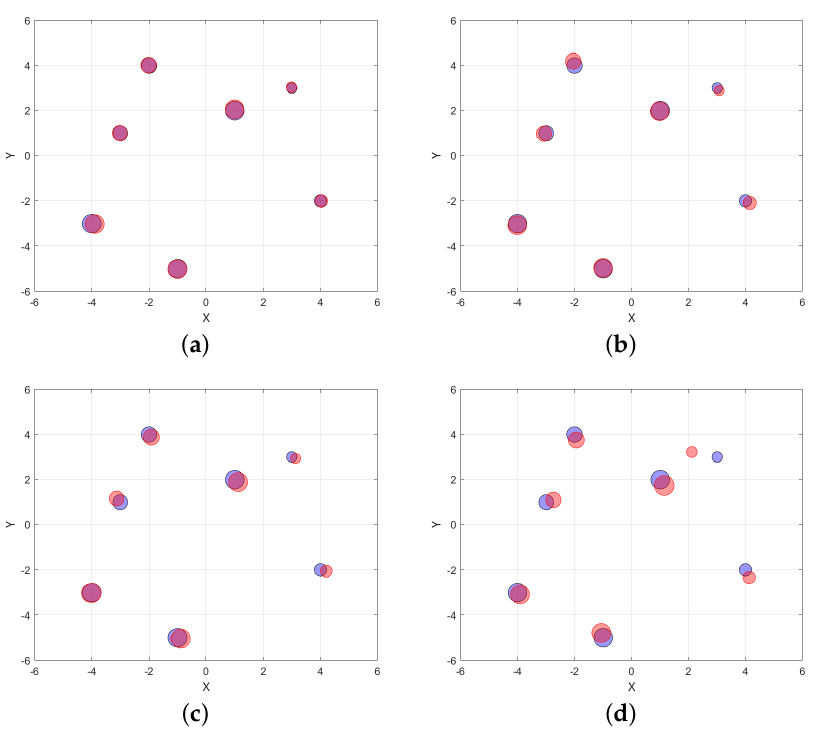
Figure 9. The reconstructions of the multi-sources with different noise levels. Here, ( a – d ) represent the ε = 1%, ε = 5%, ε = 10% and ε = 20%, respectively. Table 9. Relative error of points at different noise